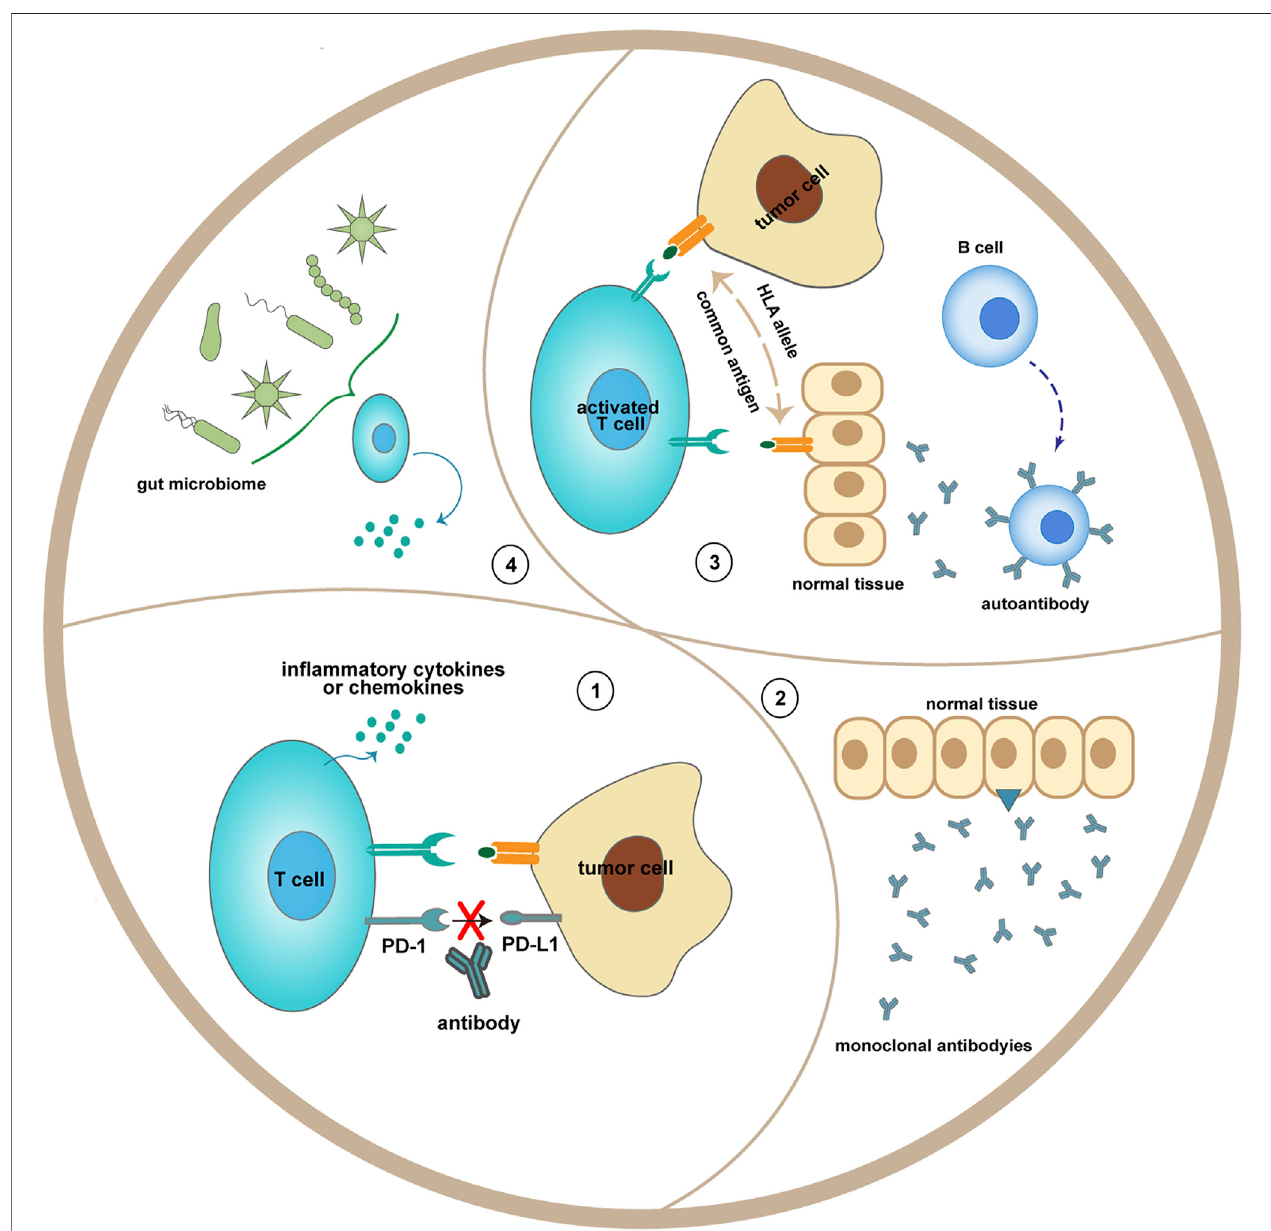
FIGURE 2| Potential mechanisms of immune-related adverse events. 1) Blocking the interaction between PD-1 on Tcells and PD-L1 on tumor cells may enhance the release ofin fl ammatorycytokines from T cells. 2) Monoclonal antibodies, likeanti-CTLA-4, may recognize antigenpresented bythe normal tissue (hypothalamic and pituitarytissues).3)OverresponseofnaivelymphocytescouldproliferateautoreactiveTcellsandBcells.4)Thegutmicrobiome,whichmaybealteredafterICItreatment, may in fl uence T-cell